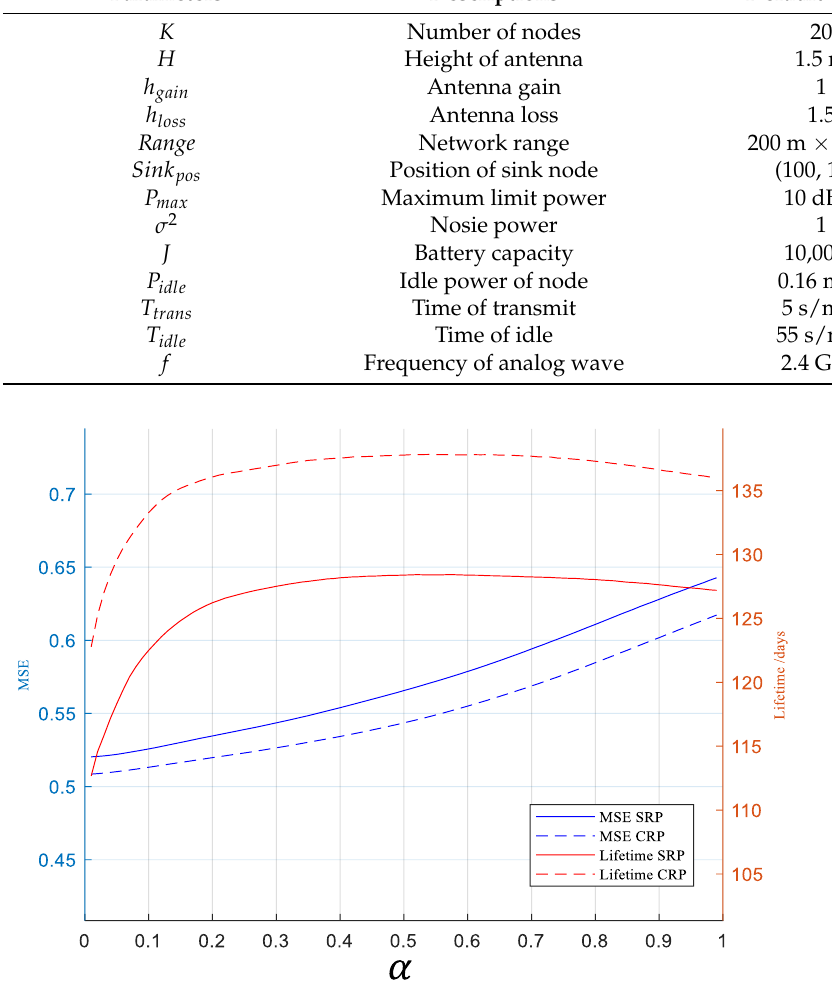
Figure 5. Variation of MSE and lifetime with respect to the parameter 𝛼 in Equation